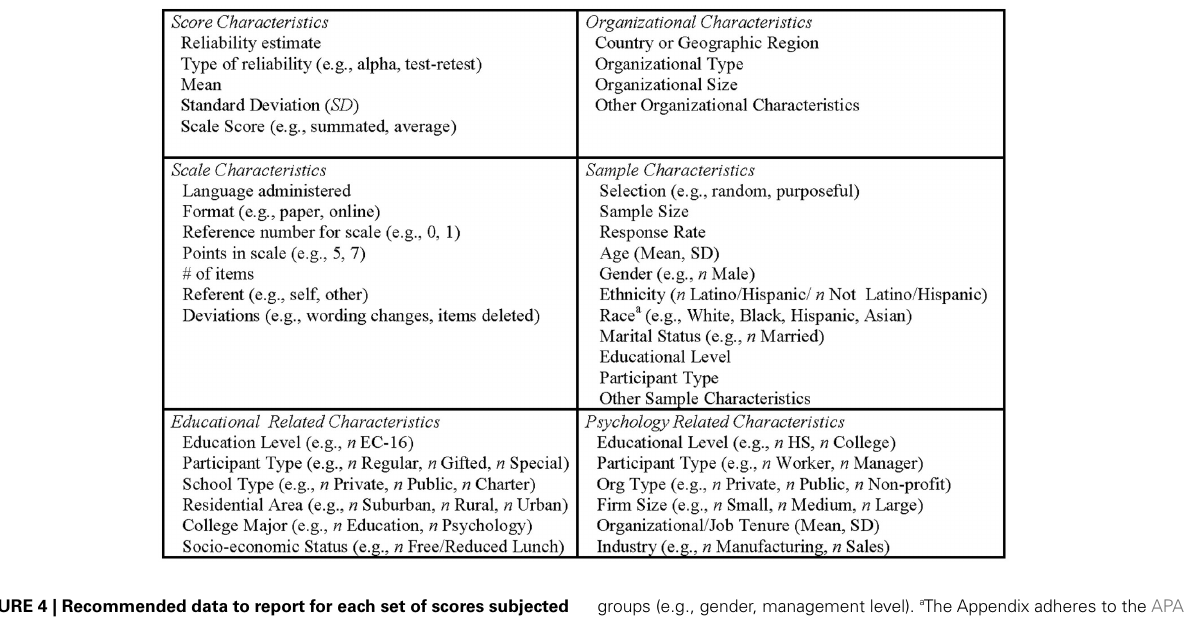
groups (e.g., gender, management level). a The Appendix adheres to the APA (2009a) recommendations for reporting race. Reporting of sample characteristics by race should follow APA (2009a)